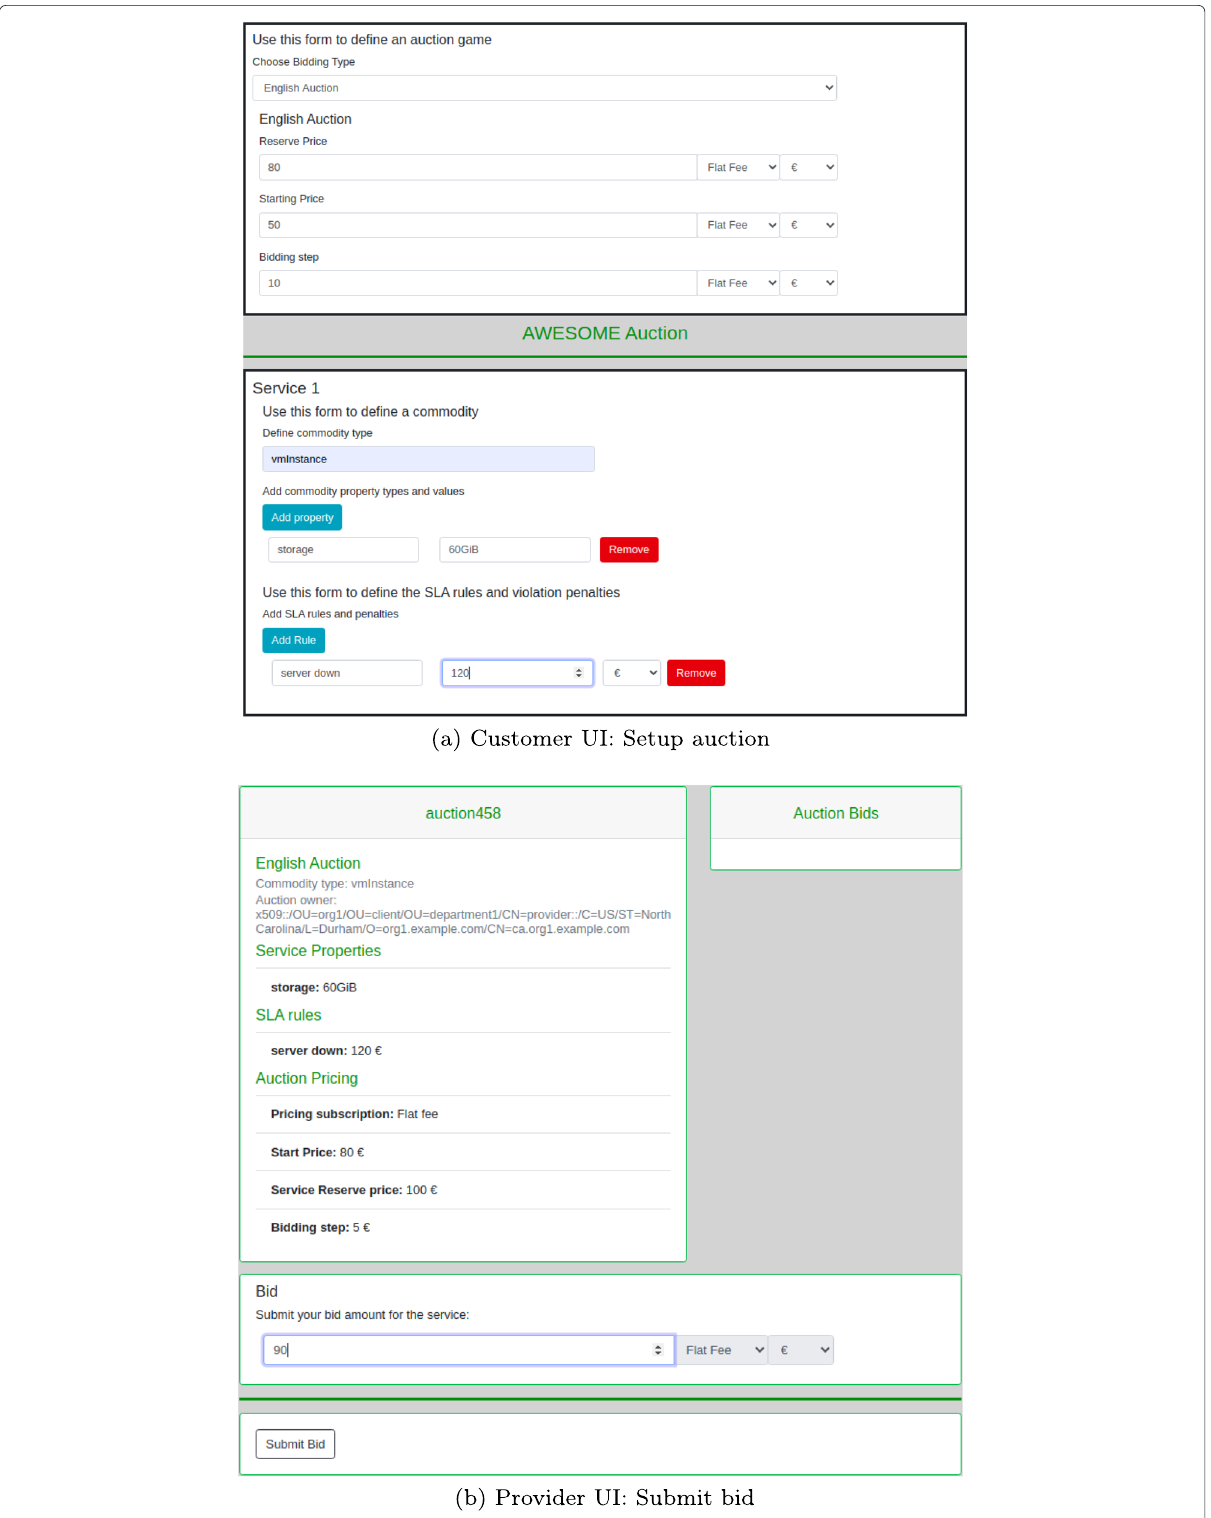
Fig. 9 The auction initiator (i.e., the customer in this auction) sets the auction rules, and bidders (i.e., providers in this auction) submit their